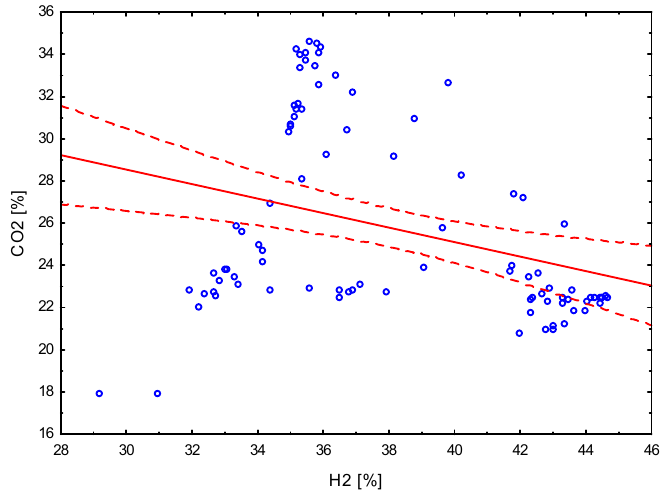
Figure 12. Correlation between percentage of CO 2 and H 2 contents.